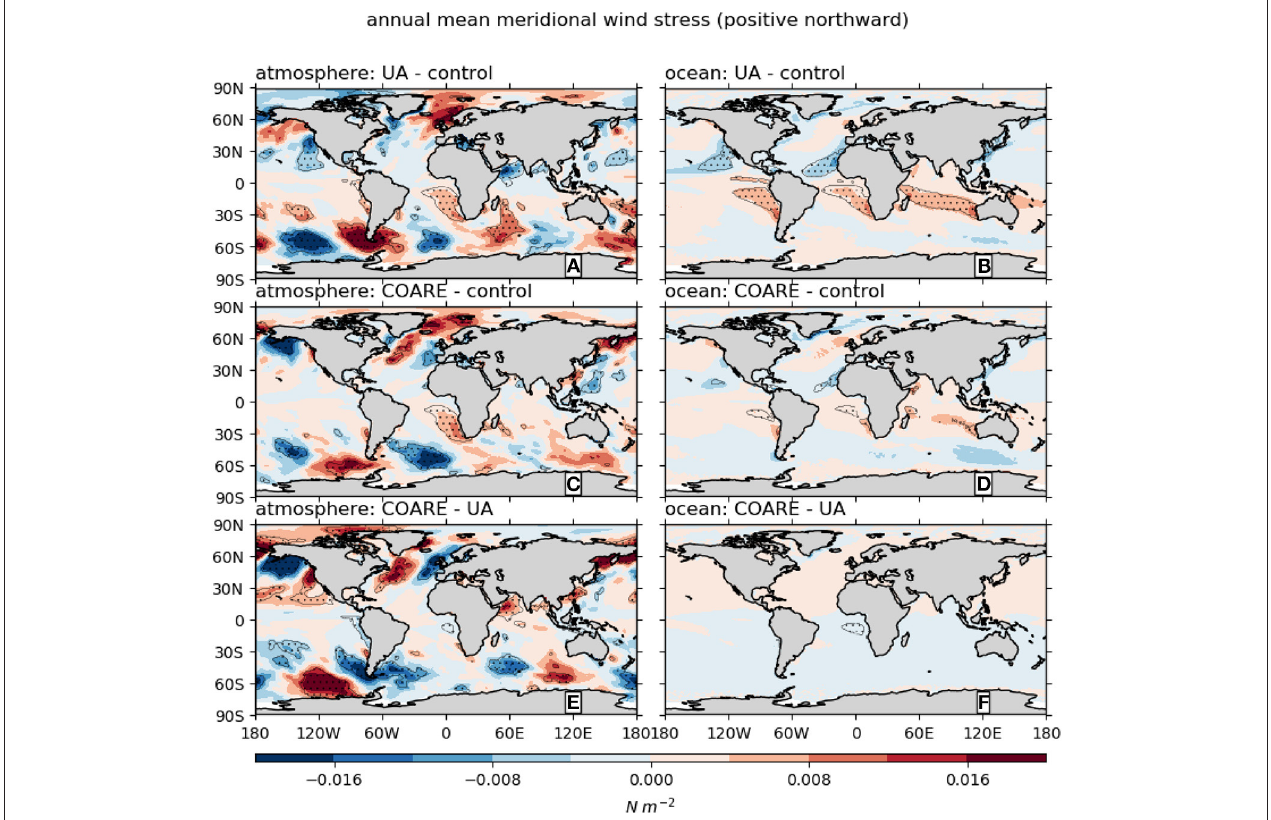
FIGURE 5 | Differences in annual mean meridional wind stress climatology between simulations with different bulk flux algorithms. The atmosphere and ocean simulation results are shown in left and right panels, respectively. Stippling designates regions where the absolute value of the difference is larger than the interannual standard deviation from the E3SMv1 pre-industrial control run. Note that the color scale is different from that in Figure 4 .